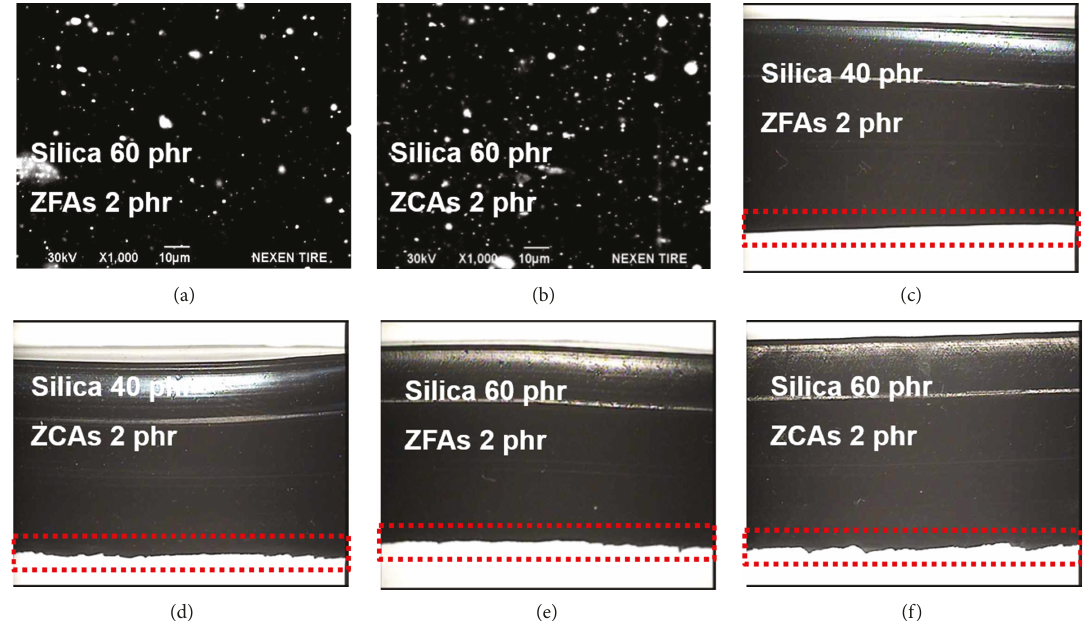
Figure 5: SEM micrographs of (a) ZFA- and (b) ZCA-rubber composites with 60 parts per hundred rubber (phr) silica. Garvey die extrusion images of (c) ZFA (2 phr)- and (d) ZCA (2 phr)-rubber composites with 40phr silica and (e) ZFA (2 phr)- and (f) ZCA (2 phr)-rubber composites with 60phr